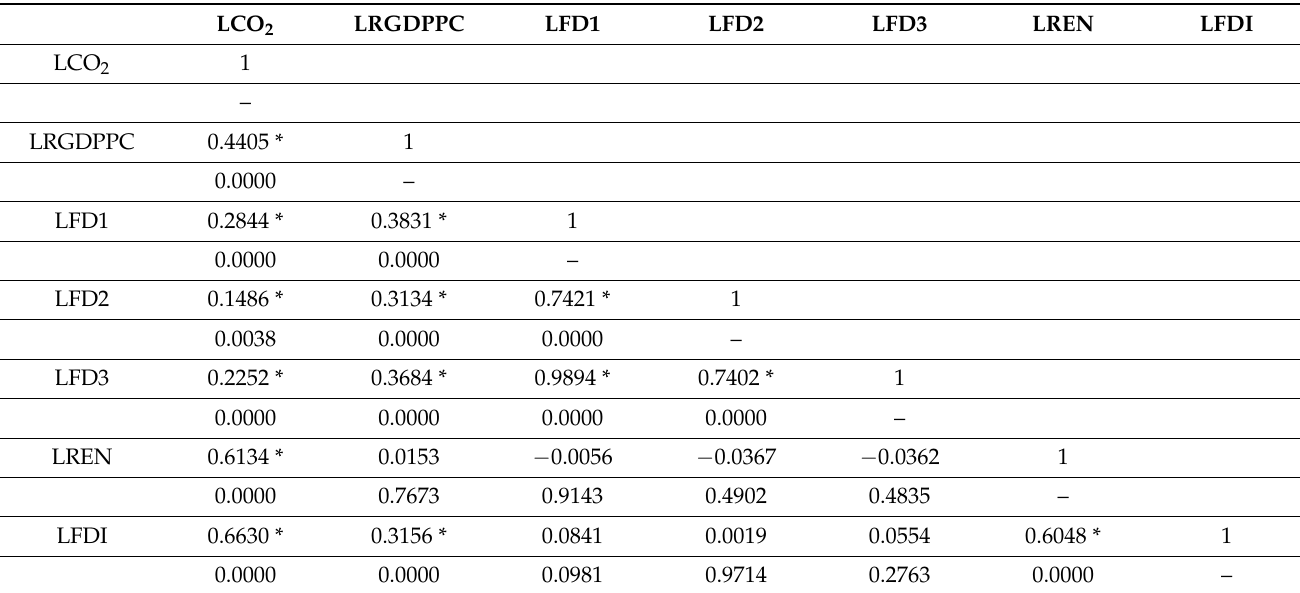
Figure 1. Binned scatterplots of the variables. Table 3. Pairwise